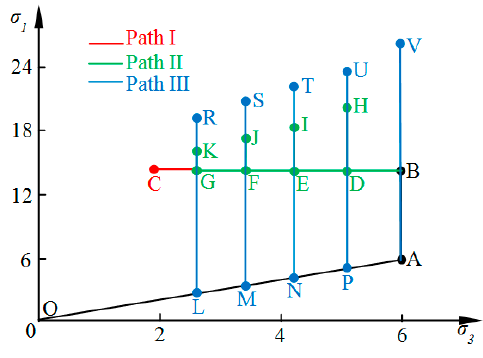
Figure 4. Stress paths of the tests. Table 3. Sample sizes and experimental parameters.